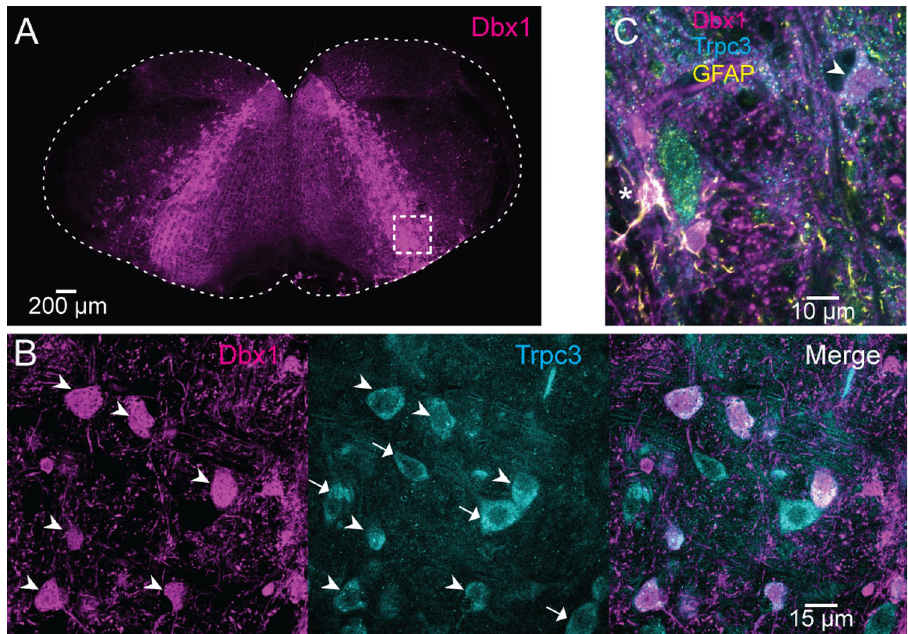
Fig 3. Trpc3 ion channels in preBo¨tC neurons. (A) Transverse section from an adult Dbx1;Ai9 mouse showing tdTomato (magenta) expression in Dbx1-derived cells. (B) Selection box from A focuses on the preBo¨tC core and shows tdTomato (Dbx1) and Trpc3 expression (cyan). Trpc3 is expressed in both Dbx1 neurons (arrowheads) and non-Dbx1 neurons (arrows). (C) GFAP expression (yellow) identifies Dbx1-derived astrocytes of the preBo¨tC (yellow and magenta, marked with an asterisk), which lack Trpc3 expression. Arrowhead identifies a Dbx1 neuron with Trpc3 expression. Separate scale bars are shown for A, B, and C. Dbx1, developing brain homeobox 1; GFAP, glial fibrillary acidic protein; preBo¨tC, pre-Bo¨tzinger complex; Trp, transient receptor potential. https://doi.org/10.1371/journal.pbio.2006094.g003 (Fig 6, 4th row, i.e., the slope of MV versus day post-shRNA was ostensibly zero, r 2 = 0.004, P = 0.5). The endpoint MV measured 0.05 ± 0.02 l/min ( n = 11). Sigh frequency significantly decreased following Trpm4 shRNA; by the endpoint, it was 30% lower, 0.42 ± 0.18 min − 1 ( P = 0.049). Trpc3 shRNA. Baseline measurements of eupnea for Trpc3 shRNA-injected mice ( n = 7) include V of 0.24 ± 0.03 ml, T of 153 ± 65 ms, frequency of 4.5 ± 1.2 Hz, and MV of T I 0.06 ± 0.02 l/min. The average baseline sigh frequency measured 0.60 ± 0.05 min − 1 . Again, we applied linear regression to analyze breathing as a function of elapsed time fol- lowing Trpc3 shRNA injection. V and T decreased progressively (Fig 6, 1st and 2nd rows, T I